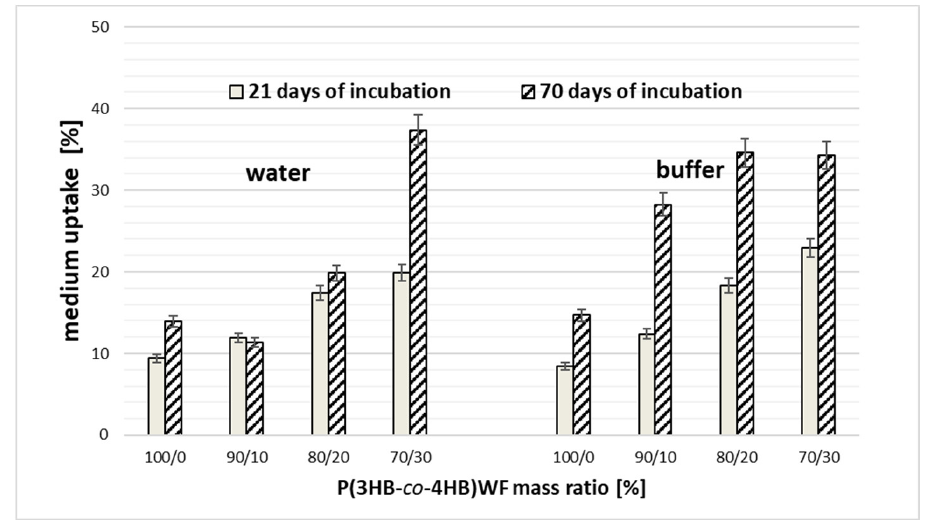
Figure 5. Mass loss of neat P(3HB- co -4HB) and P(3HB- co -4HB)/WF composites after 21 and 70 days of degradation.